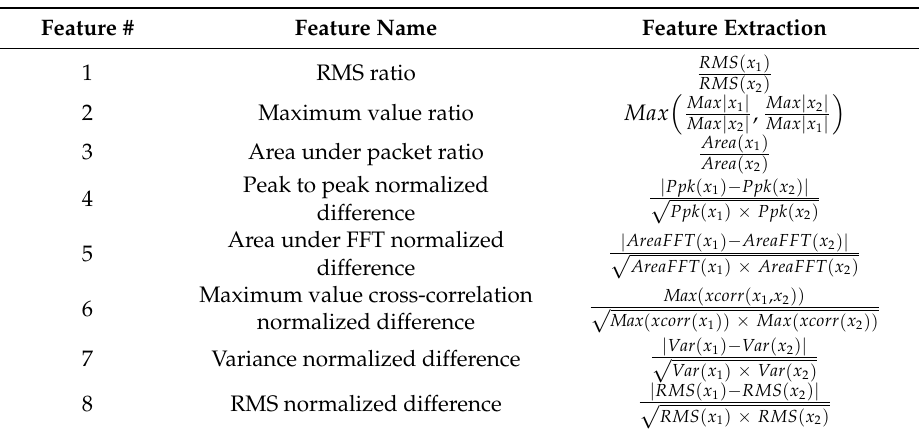
Table 2. Contact Technique Features